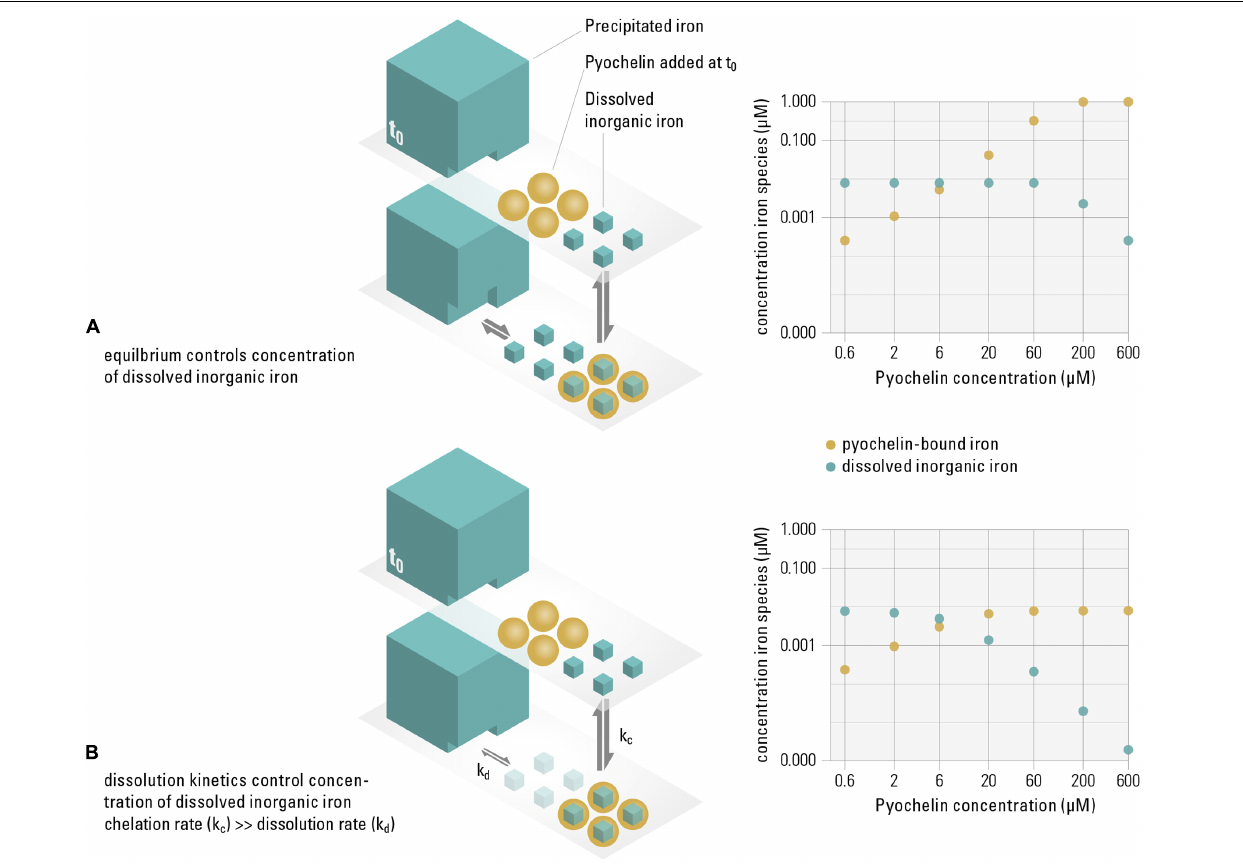
FIGURE 2 | Pyochelin can only sequester dissolved iron sufficiently if the system is not in equilibrium, but controlled by slow dissolution kinetics. In our experimental system, similar to other aerobic, pH neutral environments, 99% of the iron precipitates (i.e., a saturated system), while only around 1% is present as dissolved inorganic iron, which we assume to be available to the non-recipient (t 0 ). We consider the following two extreme scenarios. Equilibrium controlled system (A) : When pyochelin is added and the system is in equilibrium, the concentration of dissolved inorganic iron is buffered by the dissolution of precipitated phases. The thermodynamical model shows that even though the concentration of pyochelin-bound iron increases (yellow data points), the dissolved inorganic iron concentration remains constant at 0.08 µ M (turquoise data points) up to very high pyochelin concentrations. Kinetically controlled system (B) : When iron sequestered by pyochelin is not replenished due to slow dissolution kinetics of the precipitated iron, the concentration of dissolved iron can be significantly reduced. However, if slow dissolution can partially replenish dissolved iron concentrations on the timescales of the experiments, the available iron concentrations to the non-recipient are expected to be in between these extreme scenarios illustrated. Thermodynamic modeling was used to calculate concentrations of iron species for increasing pyochelin concentrations for both scenarios (data plots on the